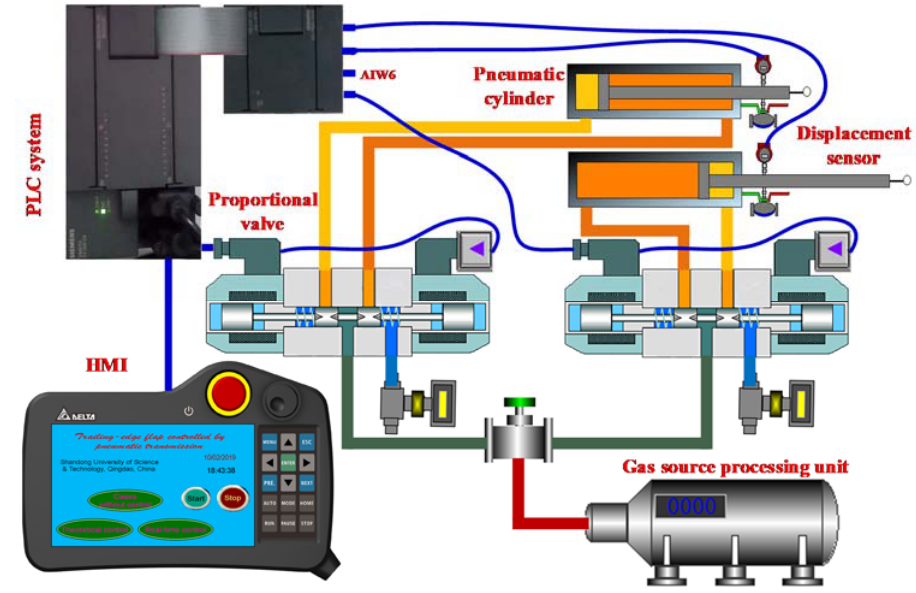
Figure 8. The experimental platform used for project implementation.